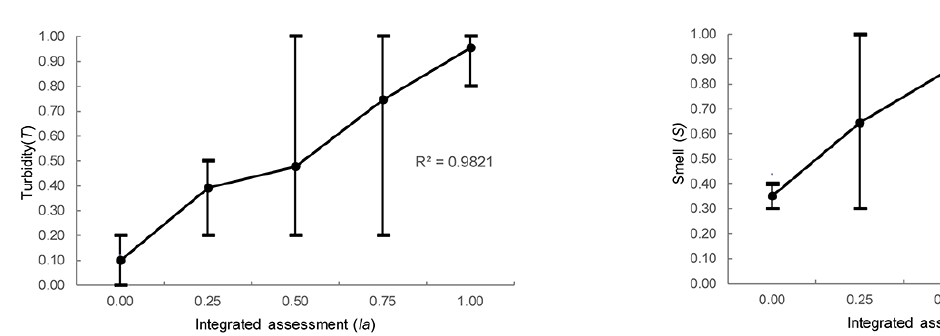
Figure 5. The correlation between I a and T .